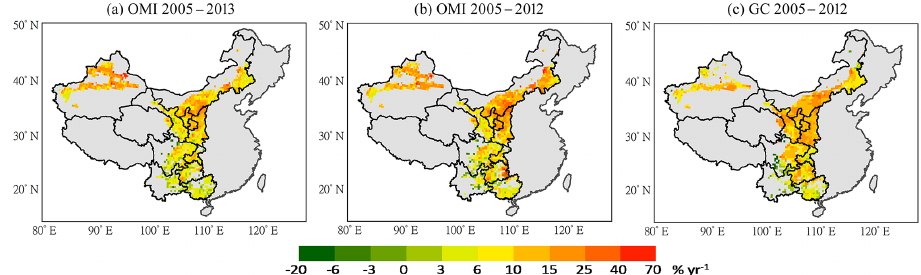
Figure 5. Percentage trends of annual mean OMI and Model NO 2 VCDs over Western China (relative to 2005), by applying a linear regression to the approximation signal A 5 from the wavelet decomposition. All the NO 2 data have been subtracted by their respective “background” values prior to the wavelet decomposition. Results are shown only for grid cells with 2005–2013 average NO 2 VCDs exceeding 1.0 × 10 15 moleculescm − 2 and with statistically significant trends ( P value<0.05 according to an F test). (a) OMI NO 2 trends from 2005 to 2013, (b) OMI NO 2 trends from 2005 to 2012, (c) Model NO 2 trends from 2005 to 2012. Table 3. Percentage changes in modeled NO 2 from 2005 to 2012. Region With changes in Without changes in anthropogenic emissions anthropogenic emissions Gansu 70.9 − 8.4 Inner-Mongolia Northwest